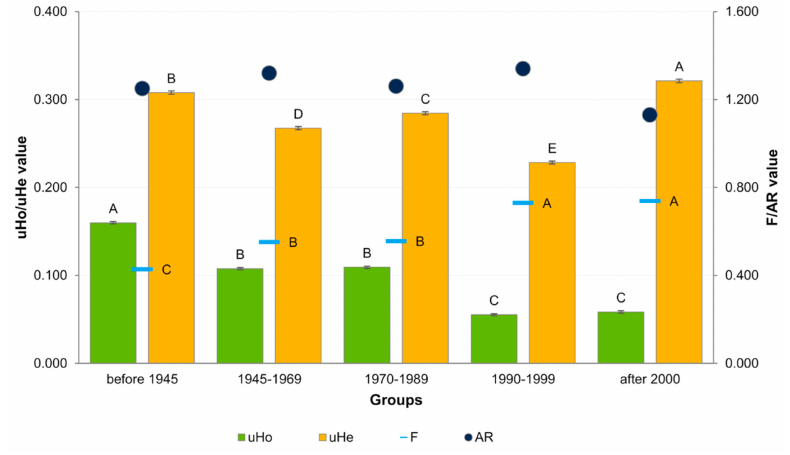
Figure 4. Summary of the diversity coefficient values for cultivar groups assigned based on the breeding date. Letters above the bars in the graph indicate homogeneous groups determined by Tukey’s post hoc